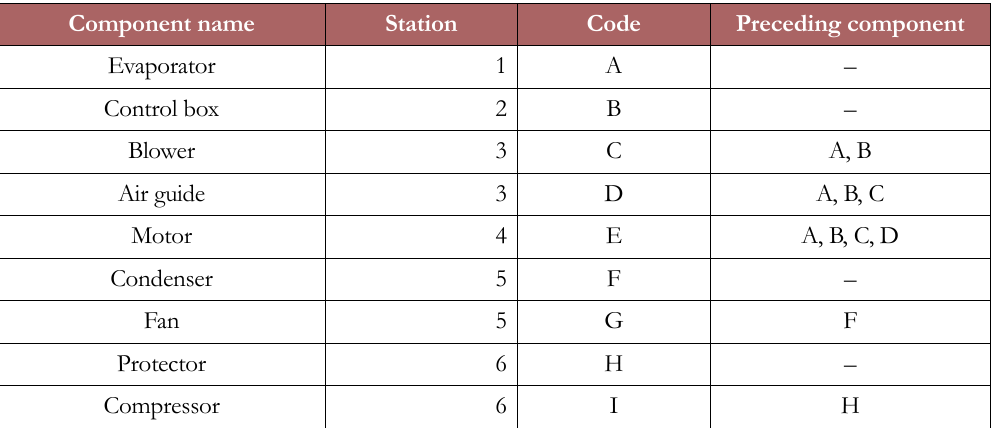
Table 1. AC Components and precedence